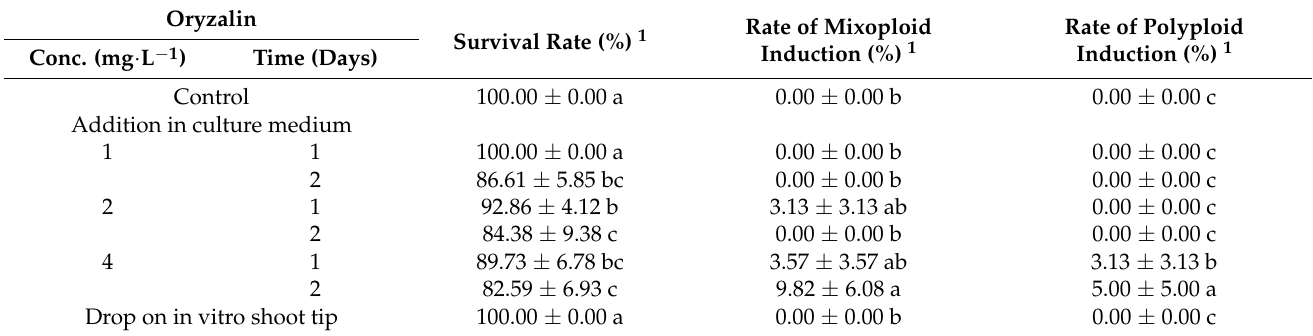
Table 1. Effect of various concentrations of oryzalin on polyploid induction in C. officinale .